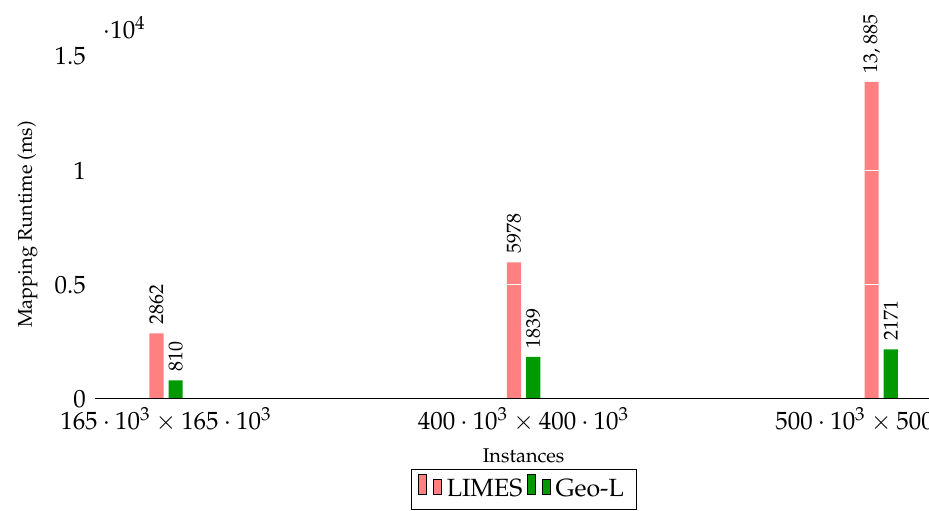
Figure 5. Performance SPOI–OLU; topological relation: within.